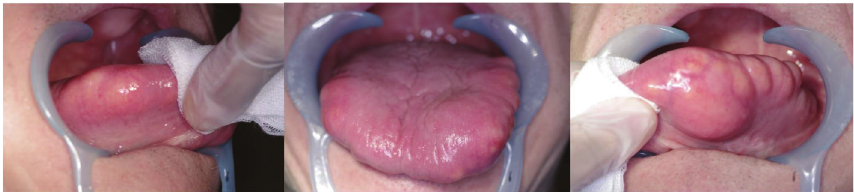
Figure 1: Intraoral findings at the first visit. Multilocular tumors were found on the bilateral margins of the tongue as macroglossia.